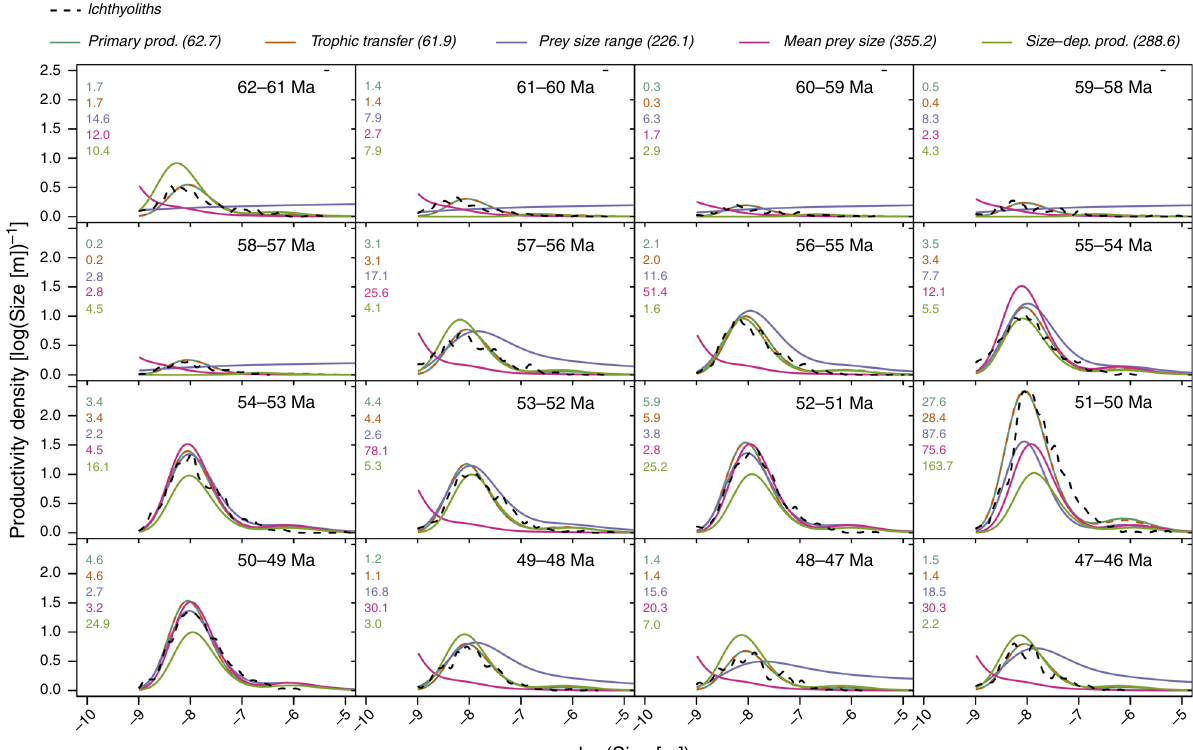
Fig. 2 Time series and model fi ts for the ichthyolith size distributions. Ichthyolith observations (dashed black line) are binned by Myr increments. Model fi ts are shown for the time-varying primary production model with constant size-productivity scaling (blue), trophic transfer ef fi ciency (orange; shown dashed in the fi gure due to overlap with the primary production model), prey size range (purple), mean prey size (red), and time-varying primary production with size-dependent scaling (green). The RMSE computed for each Myr bin is displayed in the upper left corner with the same color code and order. The total RMSE across time is given in the top legend in